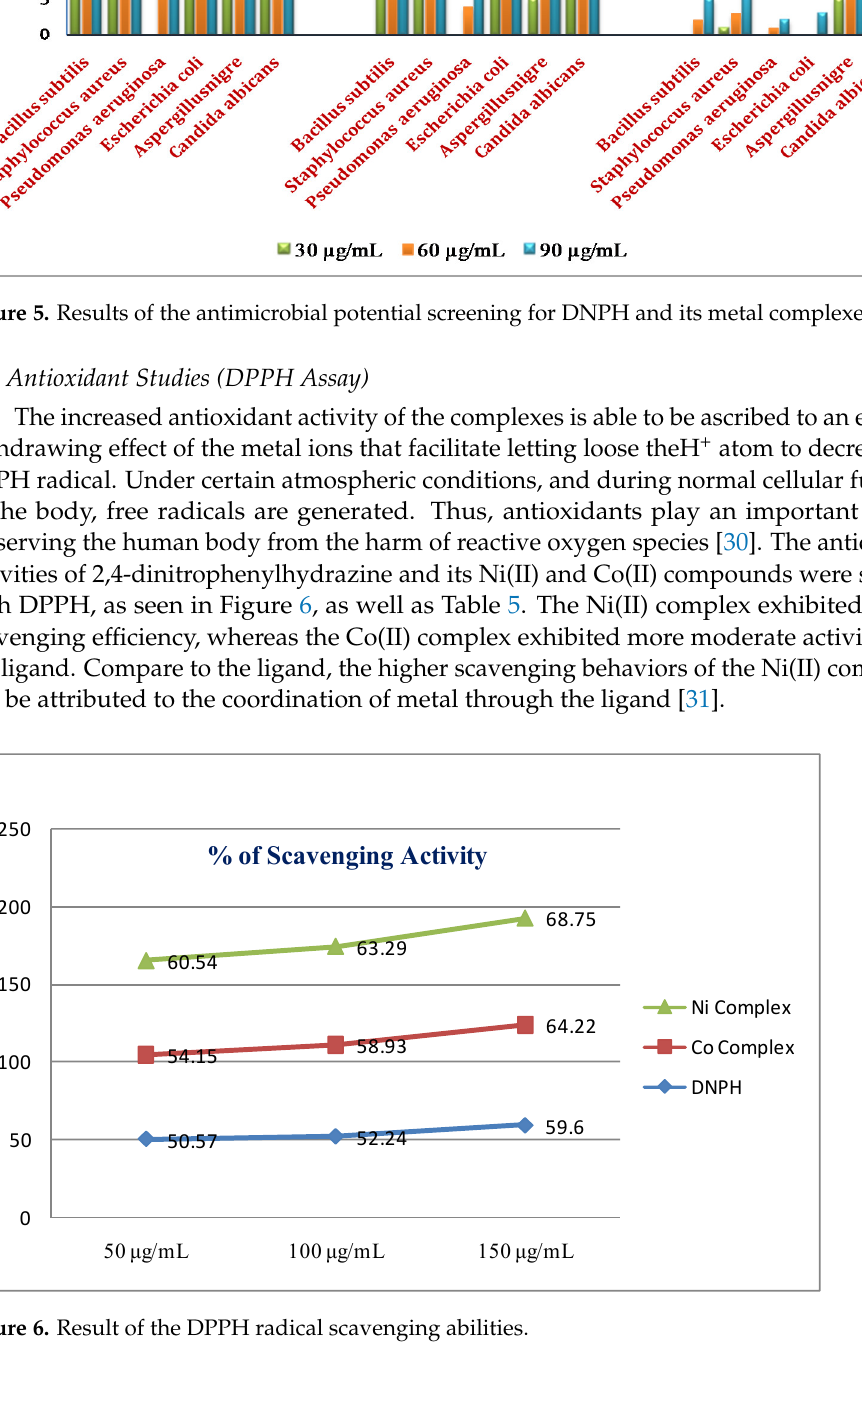
Figure 6. Result of the DPPH radical scavenging abilities.